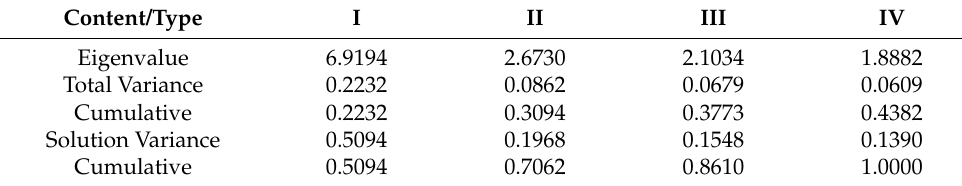
Table 1. Eigenvalues and variance for the four types of smartphone users.